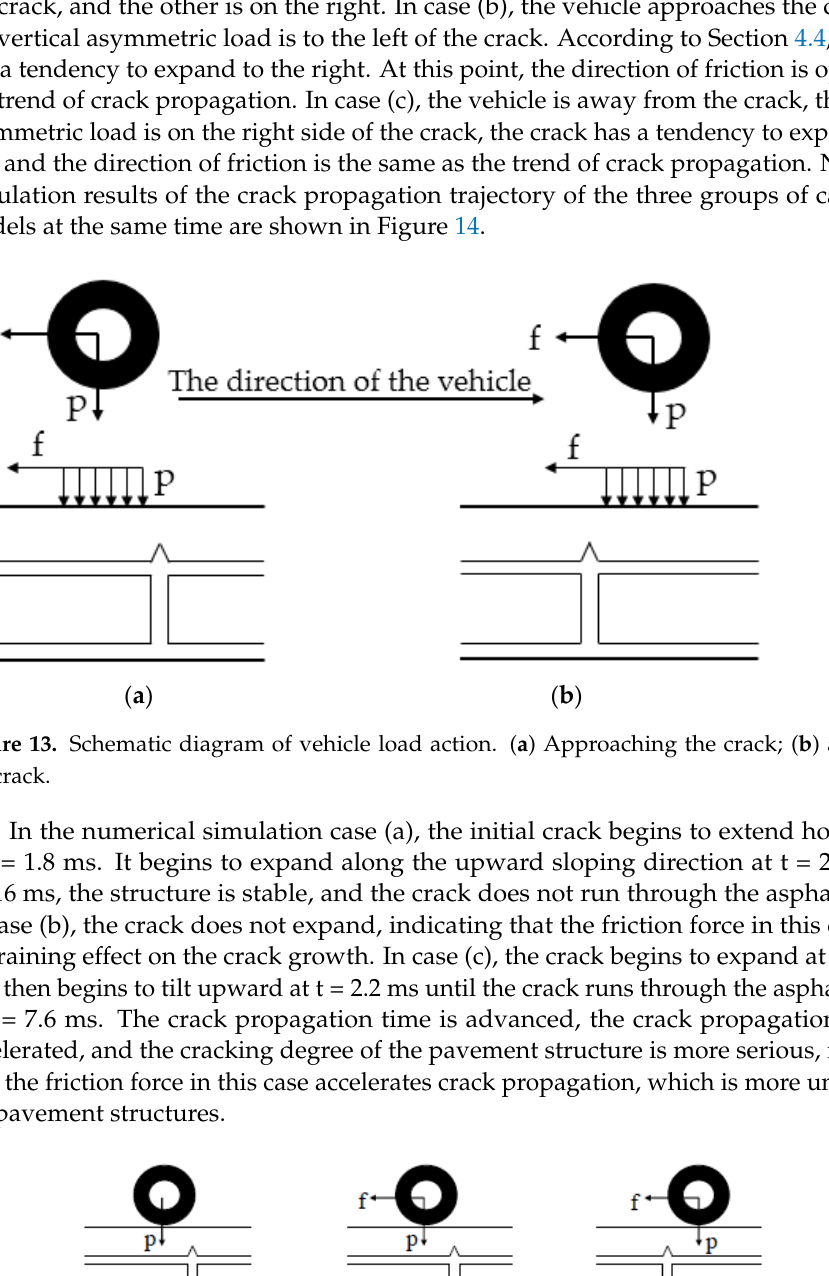
Figure 14. Crack propagation of asphalt pavement under the action of wheel friction is considered. ( a ) Vehicle load approaching the crack without friction; ( b ) vehicle load approaching the crack with friction; ( c ) vehicle load away from the crack with friction. 5. Conclusions In this paper, the theory of peridynamics was first modified and verified by three typical examples, and then the method was applied to investigate the crack propagation process of semi-rigid asphalt pavement under load from the three impacts: different forms of load, different thicknesses of asphalt surface, and wheel friction. The main conclusions are as follows: 1. A two-dimensional asphalt pavement delamination model was established by mod- ifying the theory of PD. The simulation results of the proposed model-based PD the- ory are in good agreement with the analytical solution, experimental results, and fi- nite element calculation results. The feasibility of the application of the model to